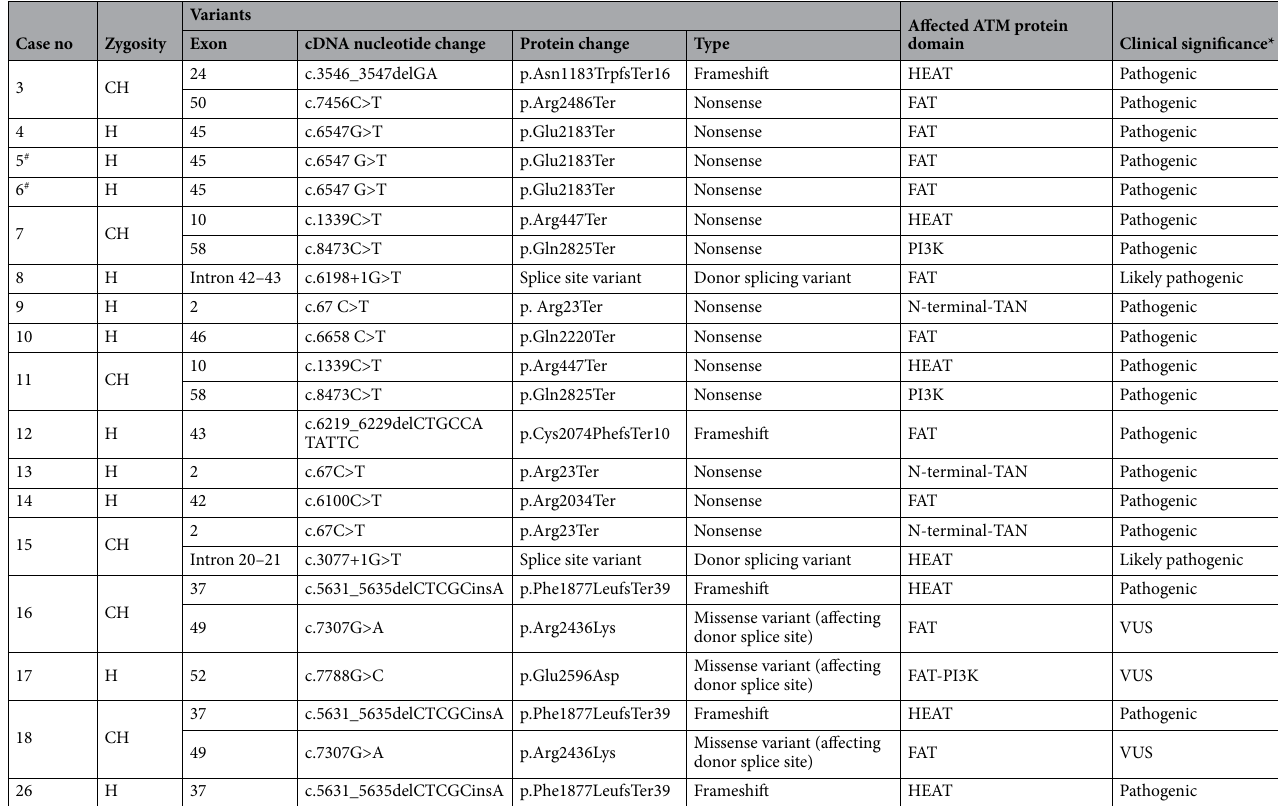
Table 3. Spectrum of ATM gene variants in the North Indian patients with A-T. # Siblings; CH compound heterozygous, H homozygous, PI3K phosphatidylinositol 3-kinase, FAT FAT domain, TAN telomere-length maintenance and DNA damage repair domain, VUS variant of uncertain significance. *As per ACMG guidelines.